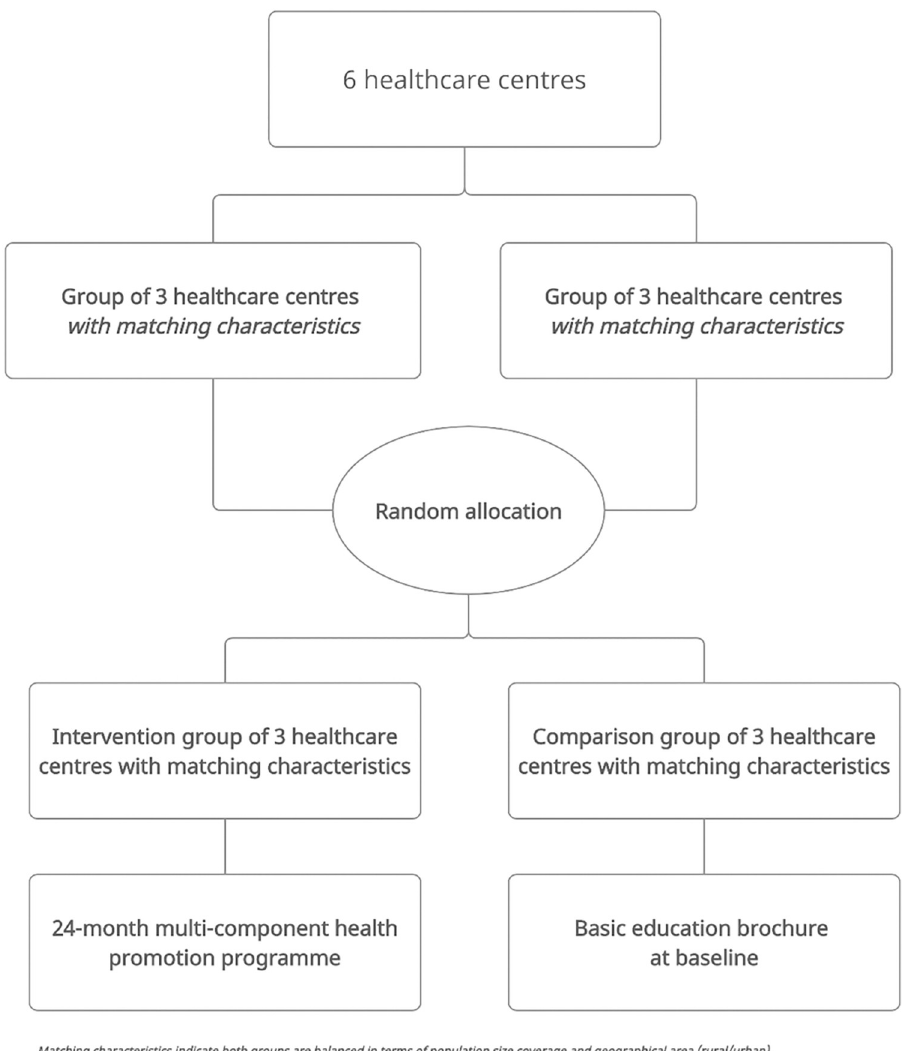
Fig 2. Study design and